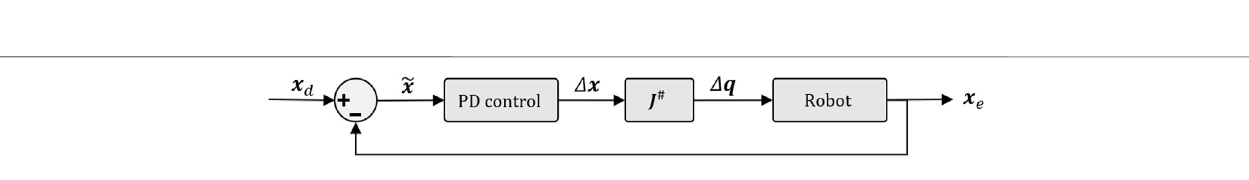
FIGURE2| Kinematic model oftherobotic systemwiththeassociatedframes,thejoystickfortheteleoperation andthetarget positions(markerand incision hole).